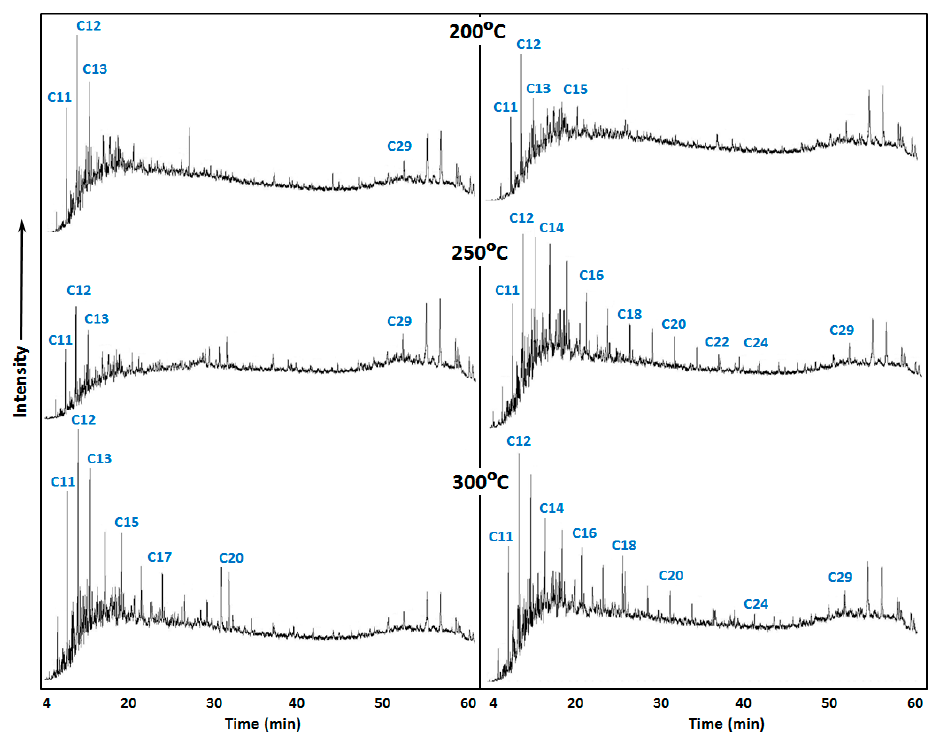
Figure 1. Gas chromatograms (GC) of saturated fractions of rock extracts under various influence temperatures in the presence ( right ) and absence ( left ) of a catalyst.